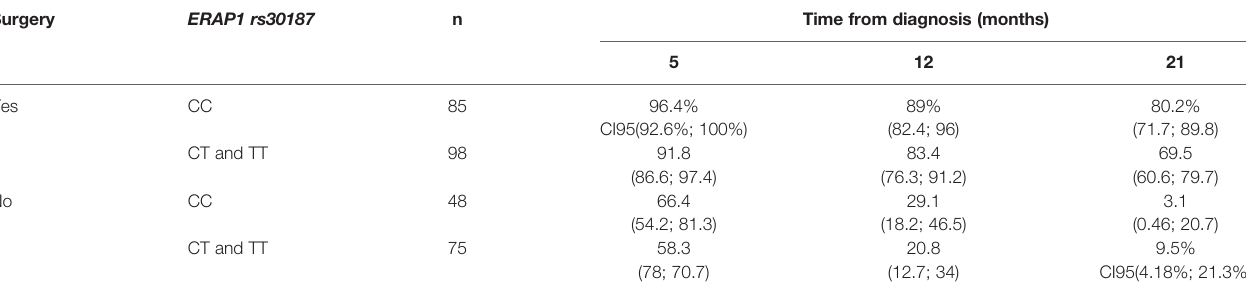
TABLE 6 | Percent of survivors after three time points: 5, 12, and 21 months after diagnosis according to type of treatment (surgery or not) and polymorphism rs30187 of the ERAP1 gene.